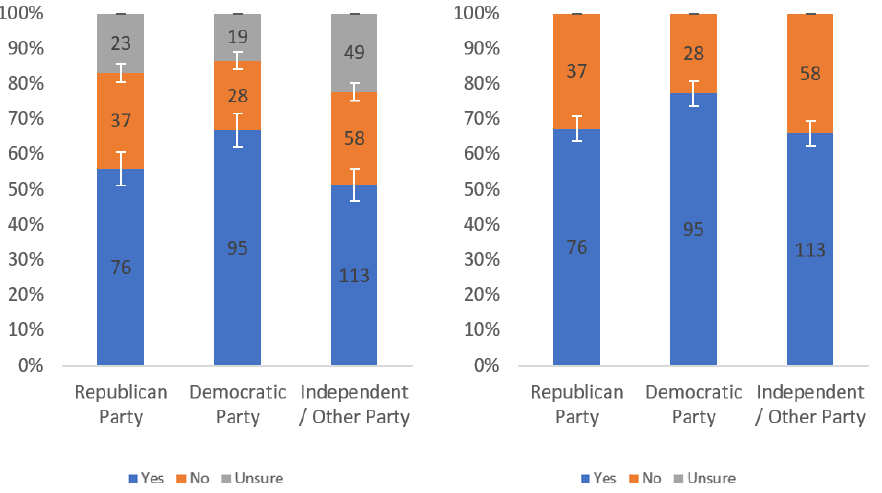
Figure 36. Responses regarding usefulness in judging trustworthiness by party affiliation including ( left ) and excluding ( right ) unsure responses.